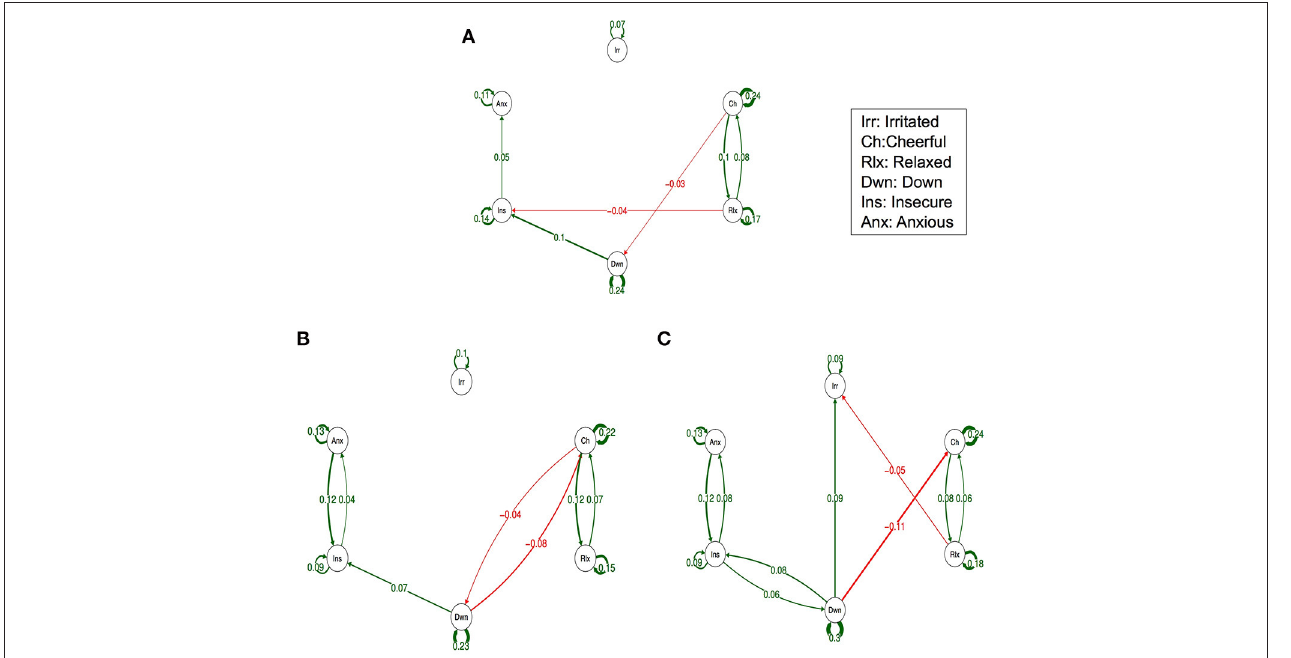
FIGURE 1 | Networks of momentary affective mental states (AMS) in subjects with low (A) , Medium (B) and high exposure to childhood trauma (C) . In this figure, the arrows represent associations over time, i.e., the B coefficient expressing the effect size of the predictive associations. For example, in the low childhood trauma network, there is an arrow from “relaxed” to “cheerful,” meaning that “relaxed” at t − 1 predicts “cheerful” at t with a B coefficient of 0.08. Green arrows represent positive associations, and red arrows represent negative associations. The linewidth represents the strength of the association and is determined by the regression weights: the wider the line, the stronger the association (and vice versa). Only significant associations after Simes correction for multiple testing are displayed (alpha is 0.0162).